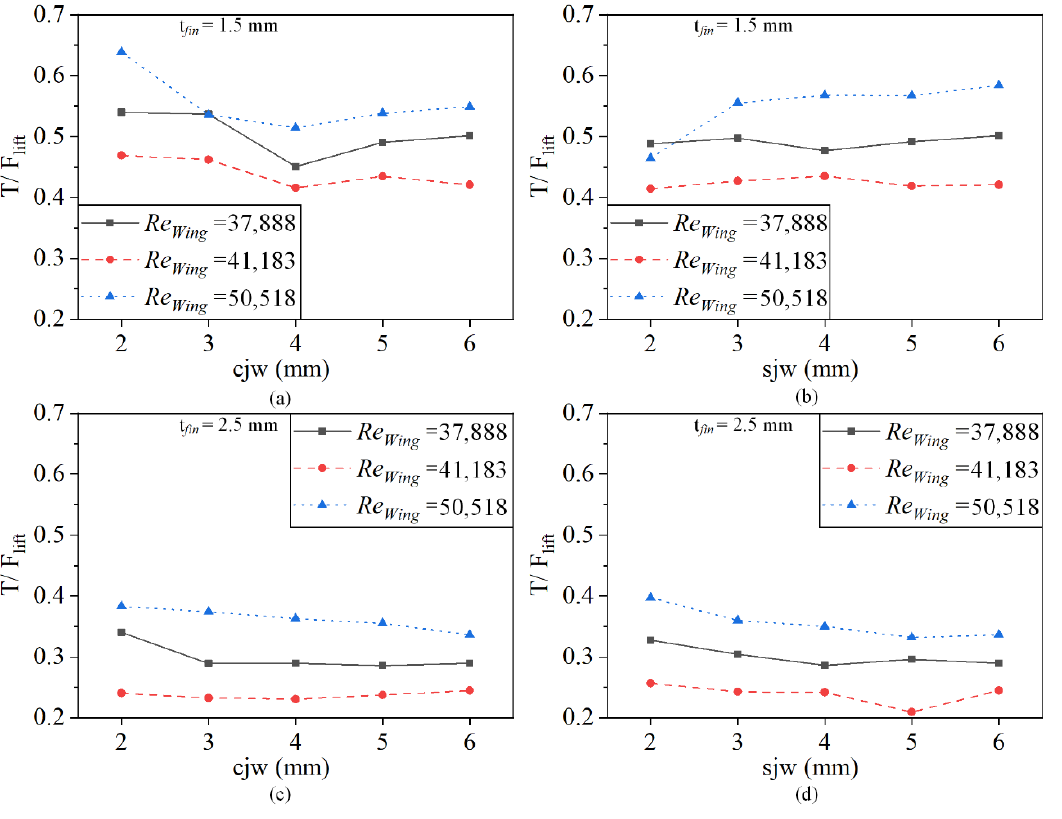
Figure 9. Variation of T/F lift with various joint widths at Re Wing > 35000. ( a ) t fin = 1.5 mm, variation of T/F lift with cjw ; ( b ) t fin = 1.5 mm, variation of T/F lift with sjw ; ( c ) t fin = 2.5 mm, variation of T/F lift with cjw ; ( d ) t fin = 2.5 mm, variation of T/F lift with sjw .